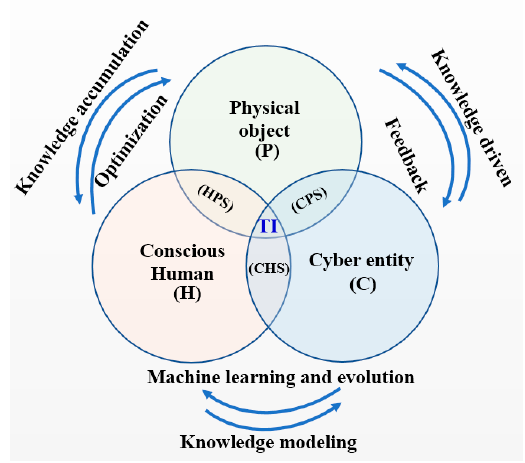
Figure 2. The Tri-X Intelligence (TI) model.